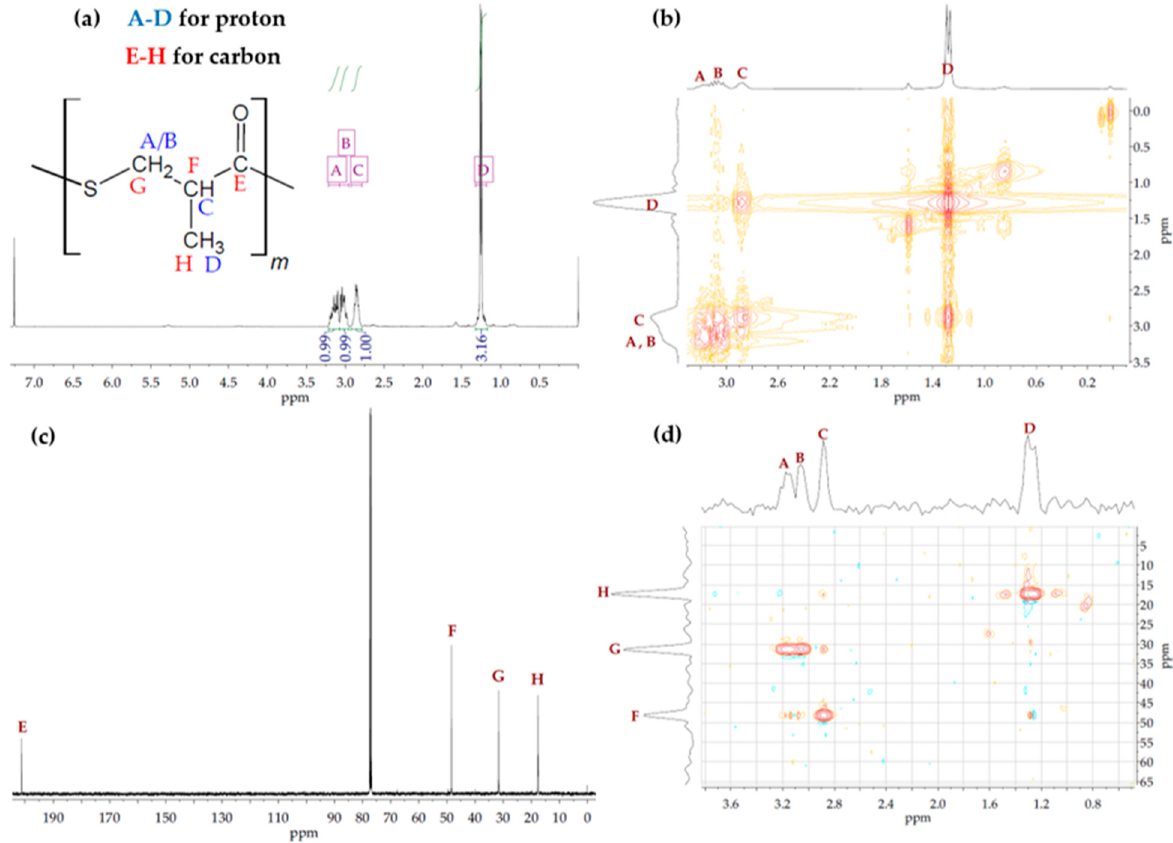
Figure 2. NMR spectra of P(3M2MP). ( a ) 1 H NMR; ( b ) 1 H- 1 H COSY NMR; ( c ) 13 C NMR; and ( d ) 1 H- 13 C HSQC NMR.